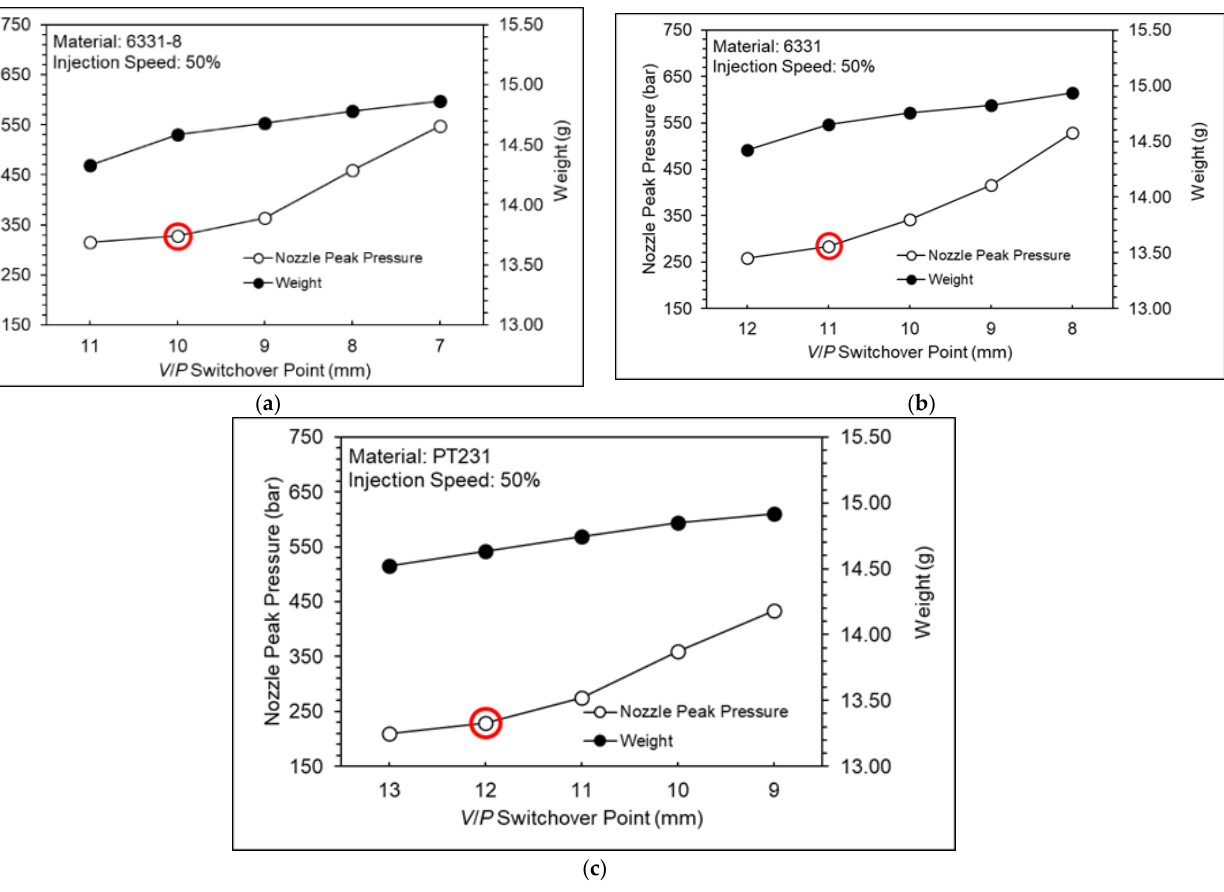
Figure 12. Nozzle peak pressure and product weight at different V/P switchover points (( a ) 6331 − 8, ( b ) 6331, and ( c ) PT231).